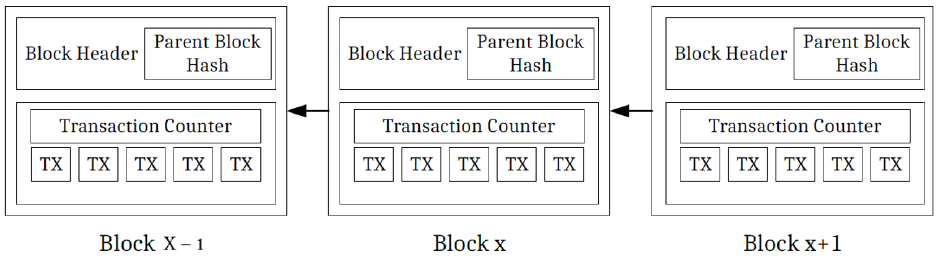
Figure 2. General blockchain structure (based on